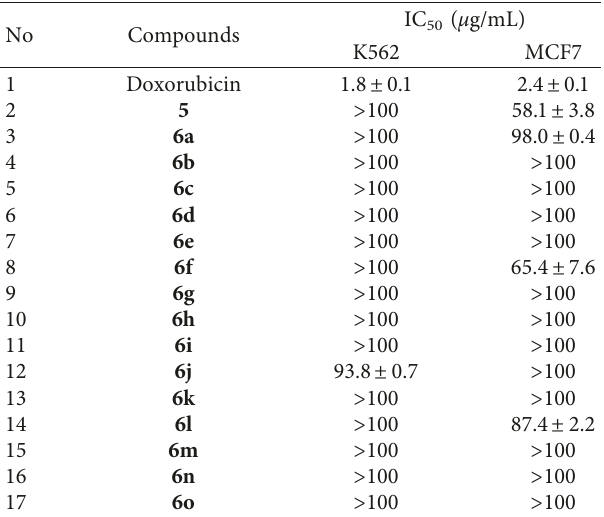
Table 2: IC 50 ( μ g/mL) on two cancer cell lines of the